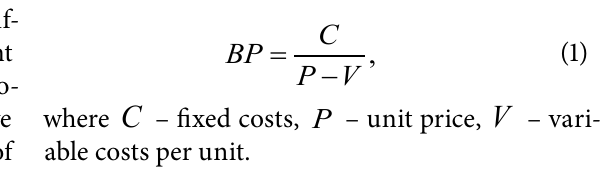
Table 2. Indicators of the enterprise’s activity in the reporting